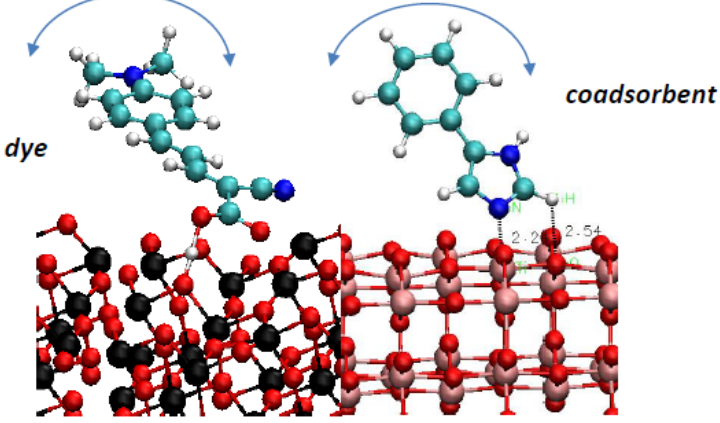
Figure 3 . Modification of the electronic properties of TiO surfaces with co-adsorbents is a 2 powerful tool to increase solar cell efficiency. In [54,55,91], we showed that adsorption modes and the nuclear dynamics of a dye adsorbed on TiO modify electron injection and 2 recombination rates (left panel: NK1 dye on anatase (101) surface). What is the effect of co-adsorbent molecules’ adsorption mode and dynamics on the electronic properties of TiO anodes of different phases, surface cuts and nano-morphologies? What are the 2 synergetic dye/co-adsorbent effects? The proposed study will answer these questions and identify optimal TiO /co-adsorbent combinations (right panel: a promising 2 4-phenylimidazole co-adsorbent on the anatase (101)